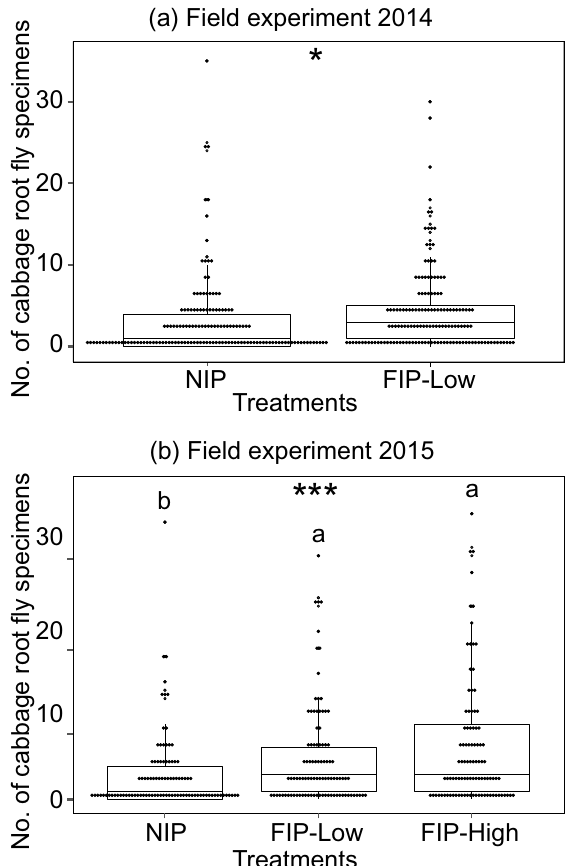
Figure 5. Symmetrical dot-density plot with superimposed box plot showing the distribution of the total number of cabbage root fly specimens collected in non-inoculated control plants (NIP) and root-associated entomopathogenic fungal (R-AEF)-inoculated plants at low (FIP-Low) and high concentrations of fungal inoculum (FIP-High) in ( a ) 2014 and ( b ) 2015. Dots represent individual sampled host plants. Boxplots visualize five summary statistics (the middle bar = median; box = inter-quartile range; bars extend to 1.5× the inter-quartile range the median). Stars represent *p < 0.05, **p < 0.01, ***p < 0.001, N.S. not significant. Letters above points indicate significant differences between types of treatments (Tukey’s test: p <